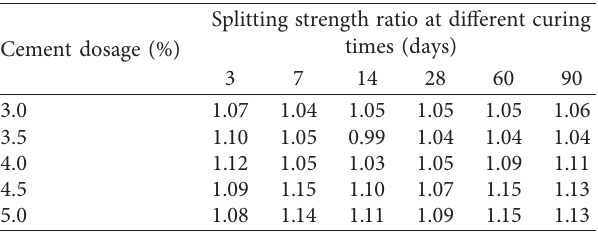
Table 10: Ratios of splitting strengths of the CSCG in the case of GM and XM gradations.